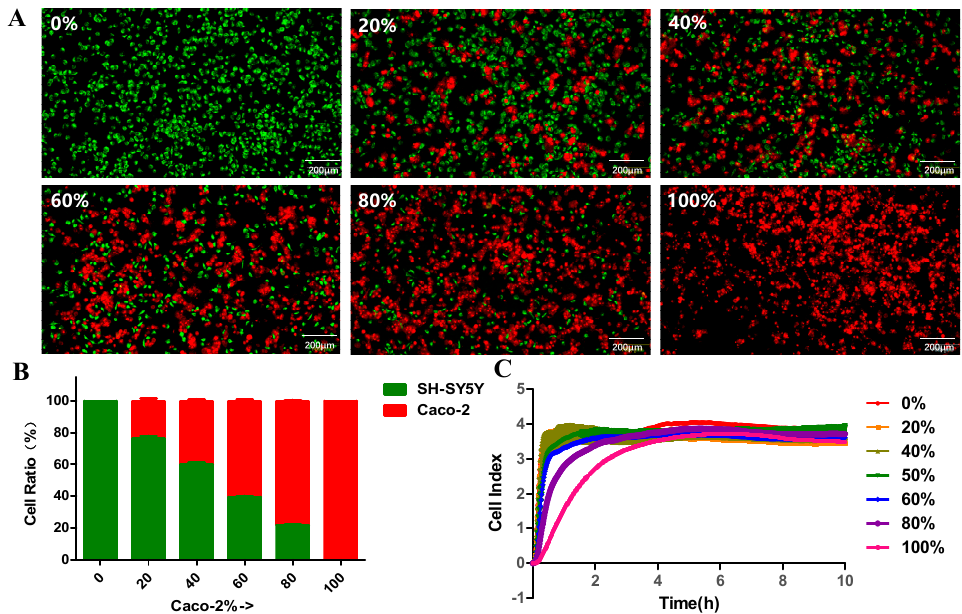
Figure 3. Cell labeling and cell growth monitoring. ( A ) Caco-2 cells and SH − SY5Y cells were labeled with PKH26 (red) and PKH67 (green) dyes, respectively; ( B ) The proportion of Caco-2 cells to SH − SY5Y cells; and ( C ) The impedance curve of the ECIS sensor reflects the logarithmic growth phase and plateau phase after different proportions of cells were inoculated onto the chip.